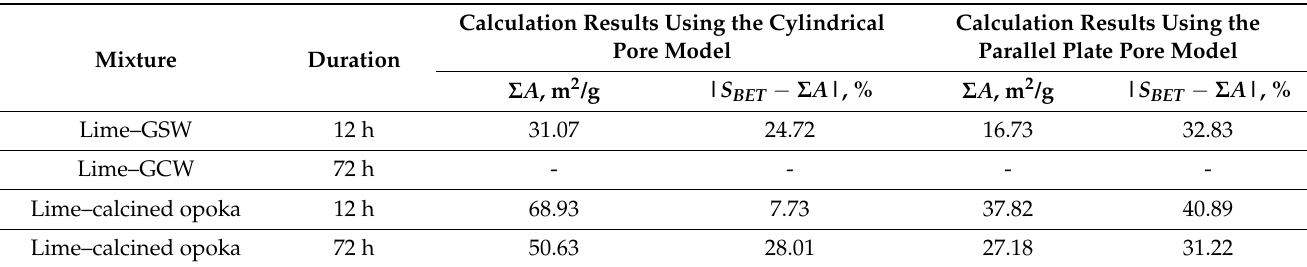
Table 4. Values of the measured and calculated specific surface area of the synthesis samples obtained at 200 ◦ C in unstirred suspensions with CaO/SiO 2 =